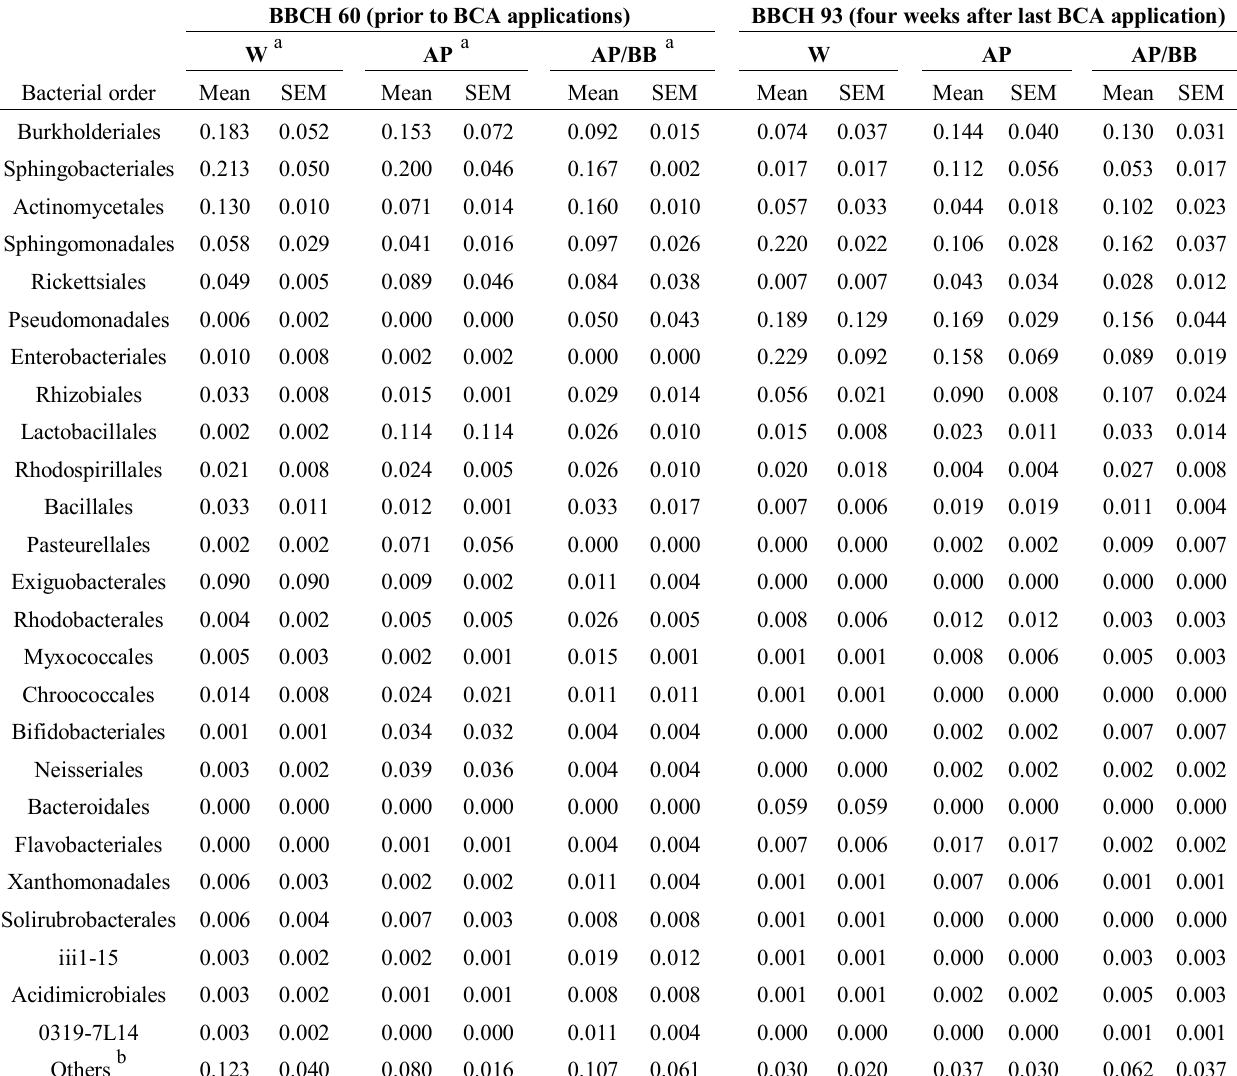
Table 4. Relative abundance of 16S rRNA reads assigned to bacterial orders in the strawberry phyllosphere at two distinct phenological stages (BBCH 60 and BBCH 93) in 2011 as influenced by treatments with Aureobasidium pullulans as a single strain treatment (AP) or co-inoculated with Beauveria bassiana (AP/BB) through commercial formulations. The control (W) was treated with water from a lotic